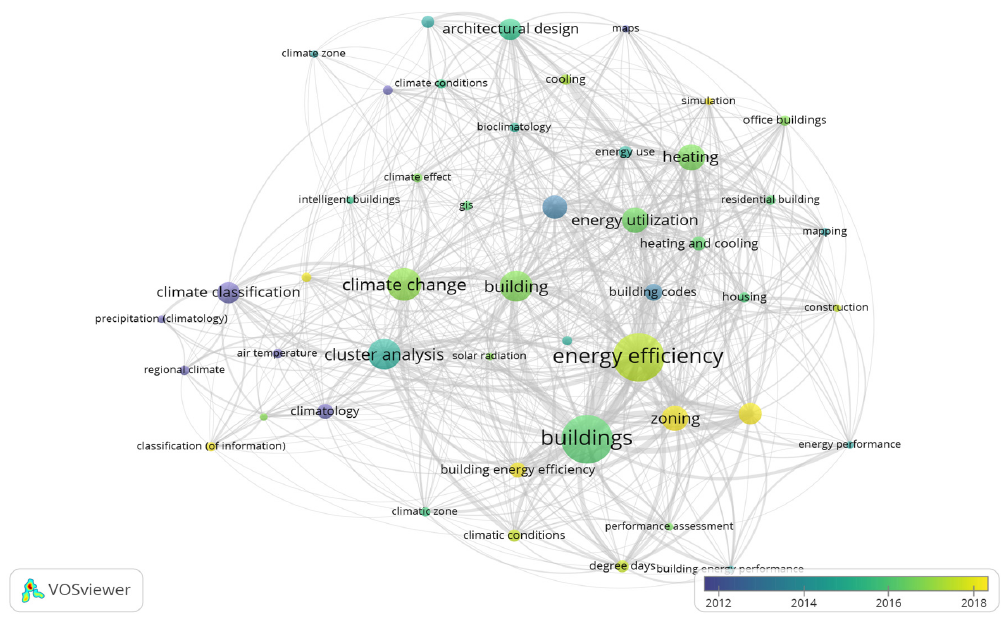
Figure 20. Co-occurrence network of keywords.